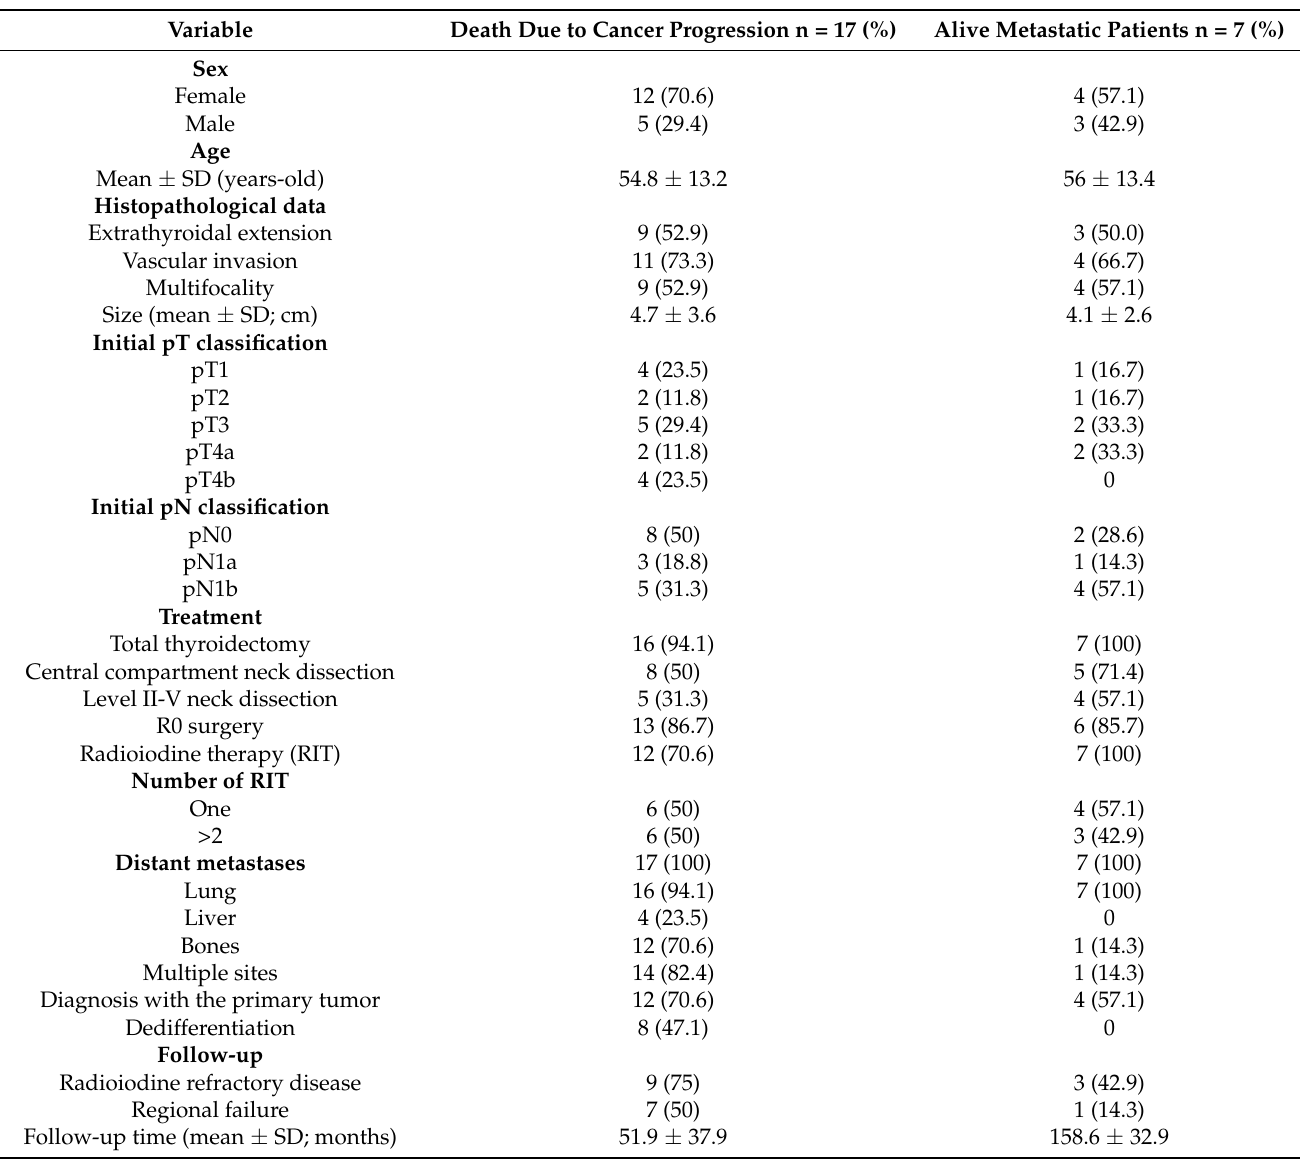
Table 1. Descriptive data of both groups of patients with metastatic papillary thyroid carcinoma included in the